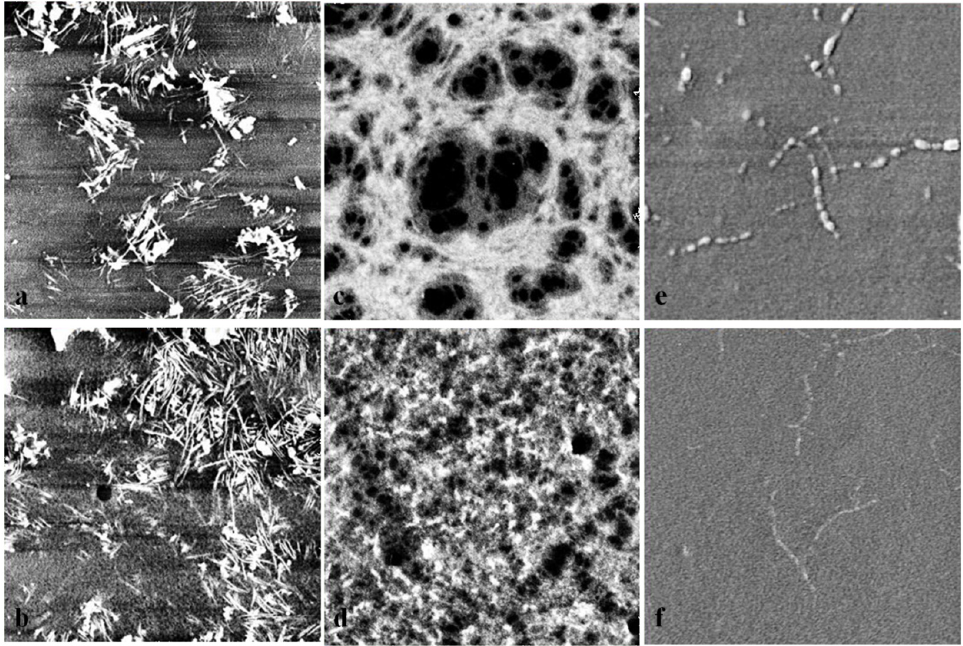
Figure 7. AFM images (3 μ m × 3 μ m) of PB 1,4 - b -P(o-Bn-L-Tyr) in room temperature and 80 °C ( a , b , respectively), PB 1,2 - b -P(o-Bn-L-Tyr) in room temperature and 80 °C ( c , d , respectively) and PI 1,4 - b -P(o-Bn-L-Tyr) in room temperature and 80 °C ( e , f , respectively).